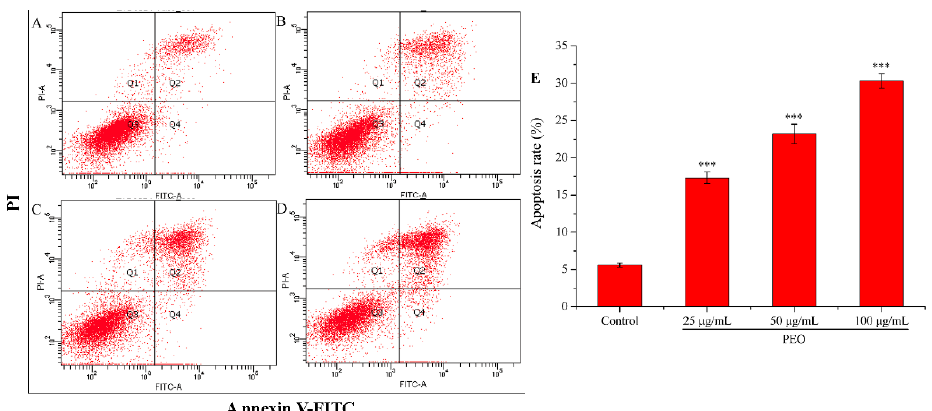
Figure 5. Cell apoptosis analysis of MGC-803 cells treated by PEO for 24 h. The A–D represented PEO concentrations were 0, 25, 50, and 100 µ g / mL, respectively; The E was the numerical histogram of apoptosis rate (*** p <